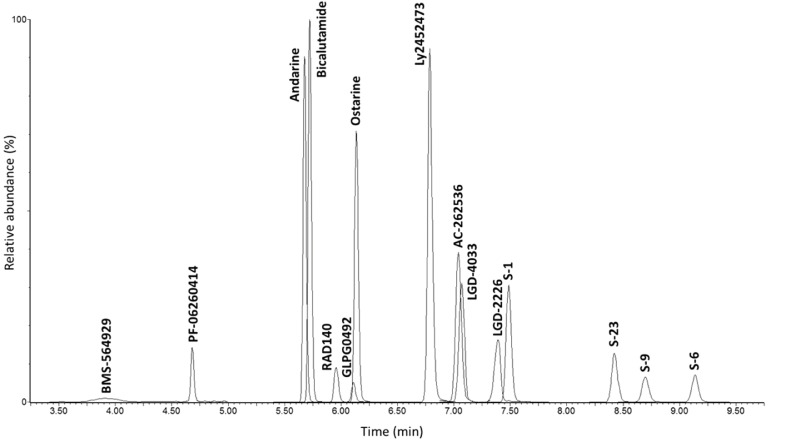
Overlay of representative extracted ion chromatograms of a blank equine urine fortified at screening target concentration (Cval) with SARMs of interest.